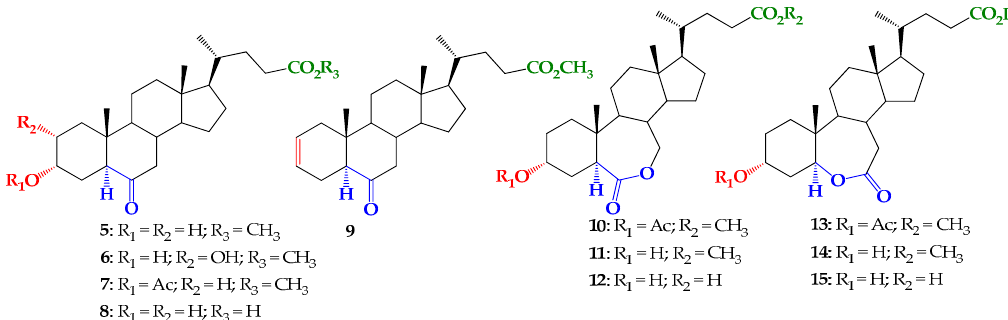
Figure 2. Brassinosteroid analogs obtained from hyodeoxycholic acid ( 4 ).